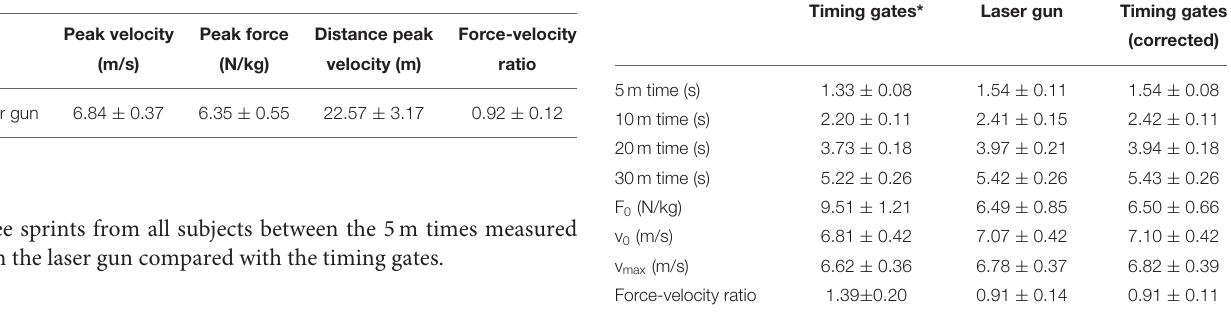
TABLE 1 | Mean ( ± SD) peak force and velocity and force-velocity ratio was measured and automatically calculated with the Musclelab TM system, together with the distance at which maximal velocity was reached over all subjects.